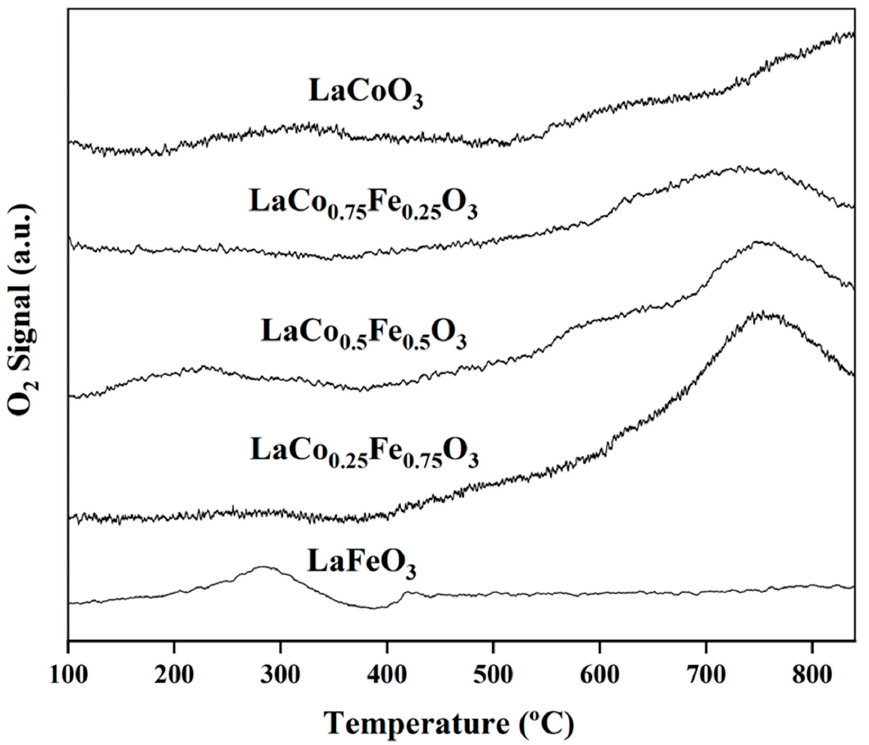
Figure 9. O 2 -TPD curves of the catalysts.